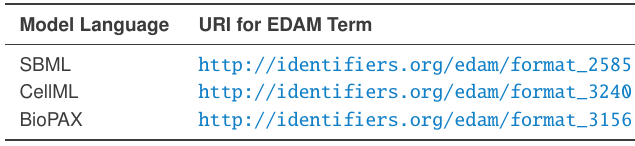
Table 10: Terms from the EDAM ontology to specify the language property of a Model .